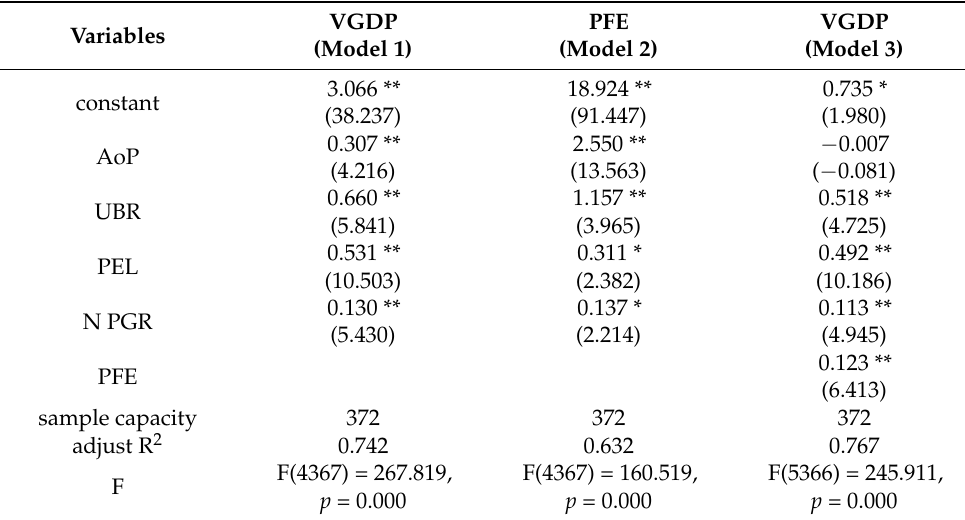
Table 6. The intermediary role of the pension fund on the relationship between population aging and economic